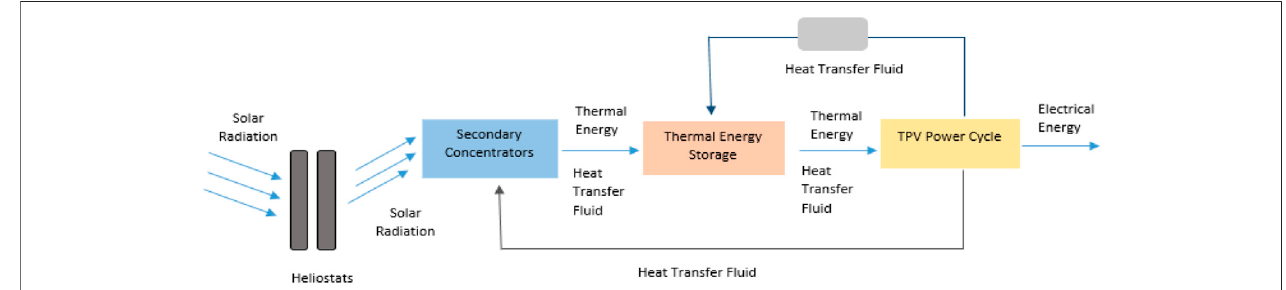
FIGURE 2 | Schematic diagram of a combined CSP-TPV power cycle shows the energy and temperature conversion of the system in which overall fl ow chart of sun rays to electrical output is shown. ” The block diagram shows the principle of energy transformation in the discussed con fi guration of a CSP plant with a TPV power